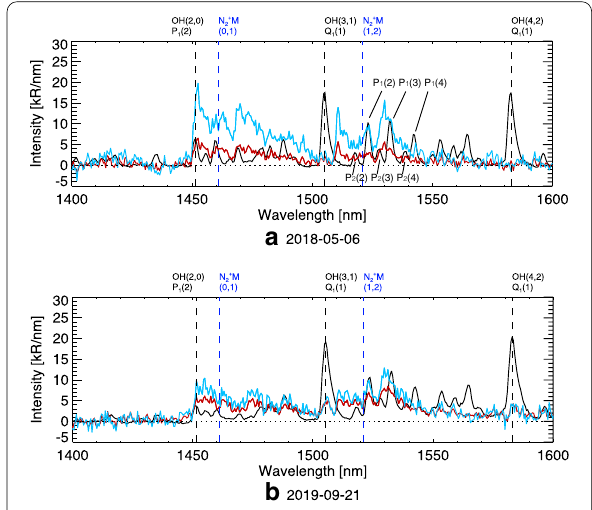
Fig. 7 Spectrum in a wavelength range from 1400 to 1600 nm obtained a at Syowa station, on May 6, 2018 and b at IRF on September 21, 2019. A black solid line is nightly mean spectrum, and therefore OH airglow emissions are thought to be dominant. Red and blue lines are spectrum observed at aurora breakup with time resolutions of 3 min (2210:00 UT on May 6, 2018 and 2152:00 UT on September 21, 2019) and 30 s (2211:00 UT on May 6, 2018 and 2154:30 UT on September 21, 2019), N + of 2 (1,2) Meinel band leading to auroral contamina- tions in OH (3,1) band in the presented cases. Figure 7a are nightly mean spectra and nominal aurora spectrum with different time windows (from 2210 to 2213 UT and from 2211:00 to 2211:30 UT) on May 6, 2018. They dem- P 1 P 1 P 2 P 2 onstrate that OH (3,1) band, mainly (2), (2), (3), P 1 N + P 2 (3), (4), and (4), was spectrally overlapped with 2 (1,2) band. Intensity of the band, which is integrated in a wavelength from 1508 to 1540 nm, was 79.5 kR in 3-min average (2.5-min exposures). In 30-s resolution data, the intensity was estimated to be 228 kR just at the moment of the aurora breakup, which causes severe contamina- tions to OH (3,1) band and subsequently leads signifi- cant errors of OH rotational temperatures. In particular, P 1 P 1 intensity of (2) and (3) lines were almost the same or N + less than that of 2 (1,2) band. Figure 7b is the same plot as Fig. 7a but obtained on September 21, 2019. Nominal aurora spectrum indicated by red and blue lines are corresponding to time windows from 2152 to 2155 UT and from 2154:30 to 2155:00 UT, respectively. In a comparison to the previous case, a spec- N + tral shape of 2 (1,2) band seems to be not well-defined. This is partly because focus adjustment was not com- pletely done. The estimated intensities in 3 min and 30 s resolutions were 160 kR and 217 kR, respectively. The two intensities in different time resolutions are not so dif- ferent, which suggests that the aurora arc did not change